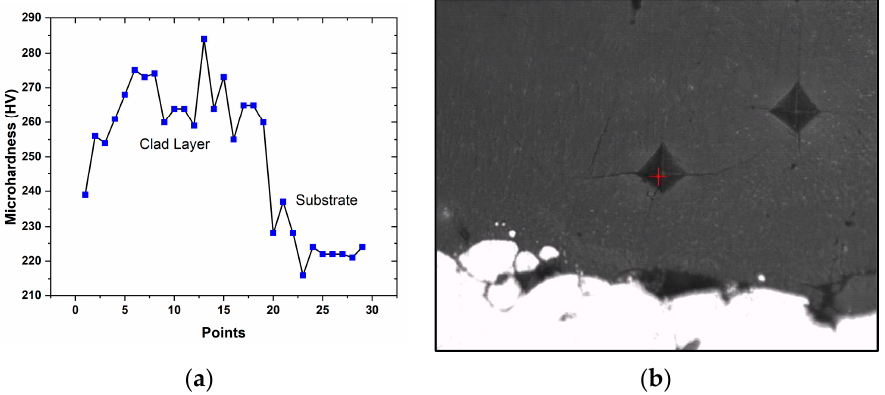
Figure 14. Microhardness: ( a ) along the clad layer, ( b ) indentation at the slag layer.